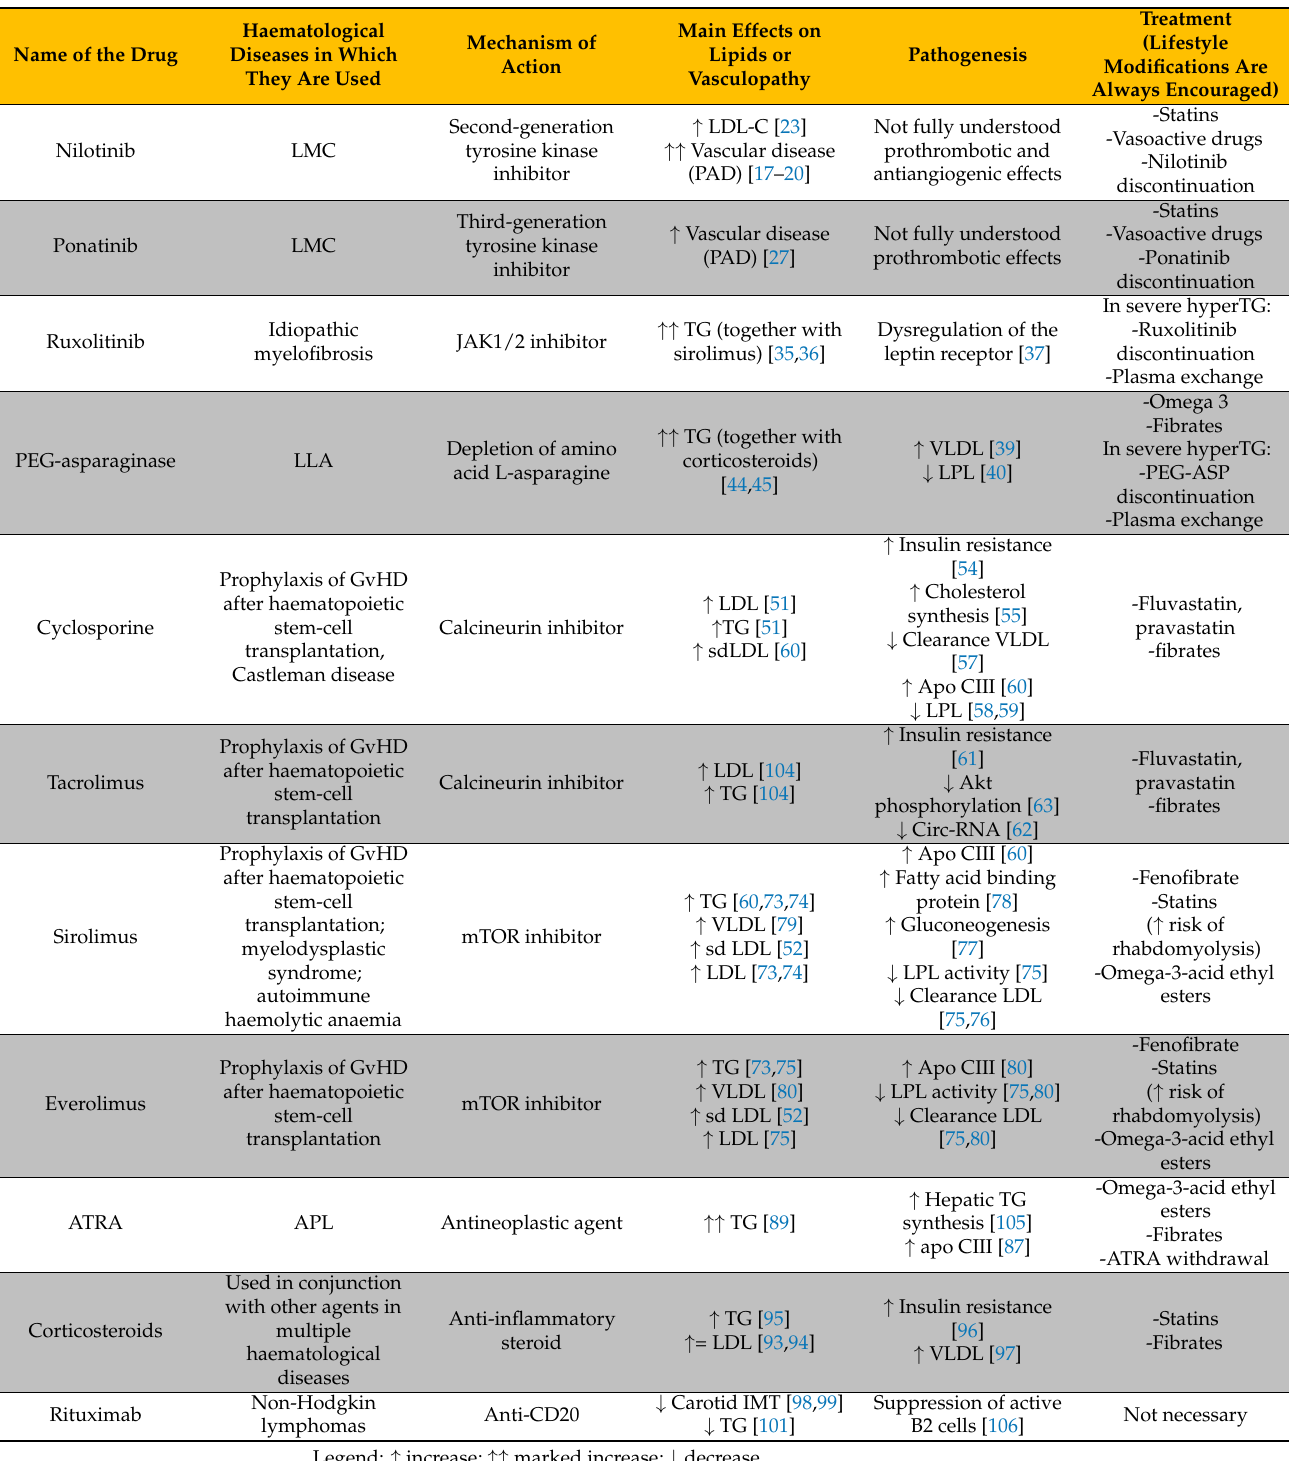
Table 2. Principal drugs used in haematology which cause dyslipidaemia or